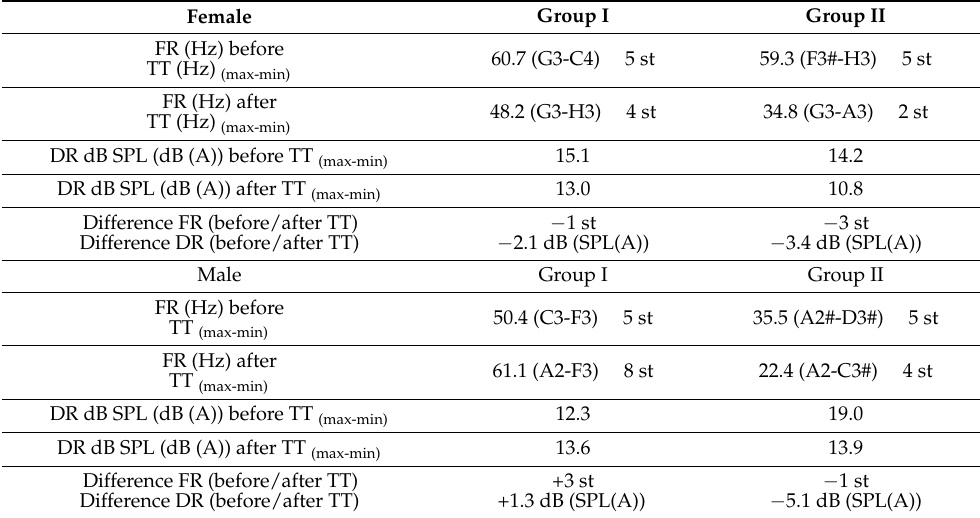
Table 2. Voice field of the speaking